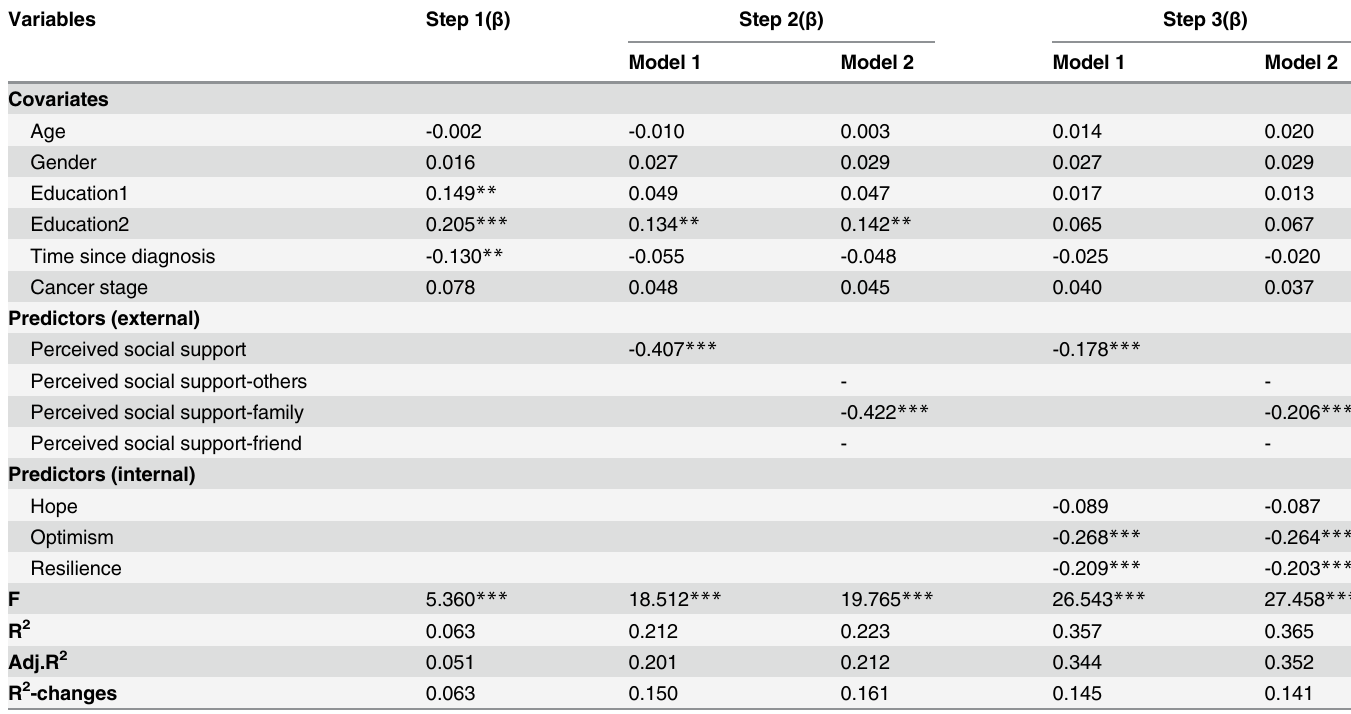
Table 5. Hierarchical regression analyses for psychosocial resources predicting